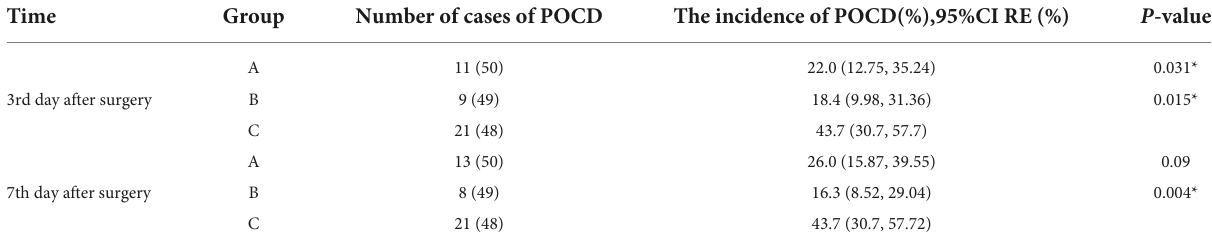
TABLE 3 Postoperative incidence of POCD in three groups (%).